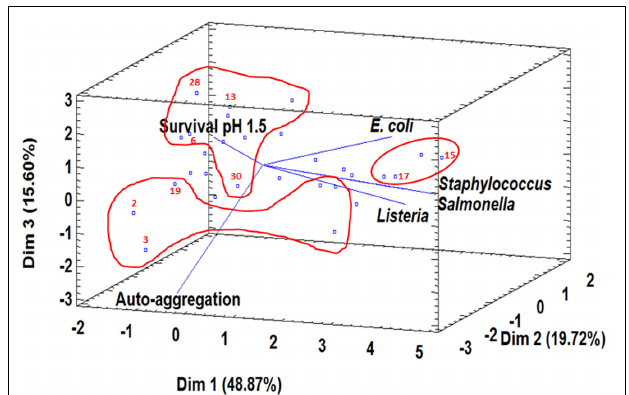
FIGURE 2 | Principal Component Analysis of six probiotic parameters (survival at pH 1.5, auto-aggregation, co-aggregation with Listeria innocua CECT 910, co-aggregation with Staphylococcus aureus CECT 4468, co-aggregation with Escherichia coli CCUG 47553, co-aggregation with Salmonella Enteritidis UJ3449) and the position of 31 L. pentosus strains. Three groups with the best scores according to three components (Dim 1, Dim 2, and Dim 3) were surrounded in red and the most representative strains (2, L. pentosus AP2-15N; 3, L. pentosus AP2-16N; 6, L. pentosus CF1-6; 13, L. pentosus CF1-39; 15, L. pentosus CF2-5; 17, L. pentosus CF2-10N; 19, L. pentosus CF2-12; 28, L. pentosus MP-10; 30, L. pentosus 5C2) were selected to be used in further